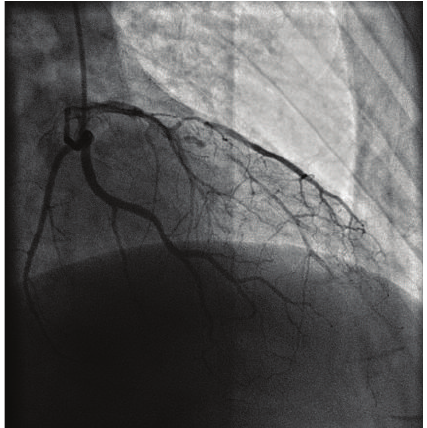
Figure 2: ECG during asymptomatic period. Figure 3: Coronary angiography.